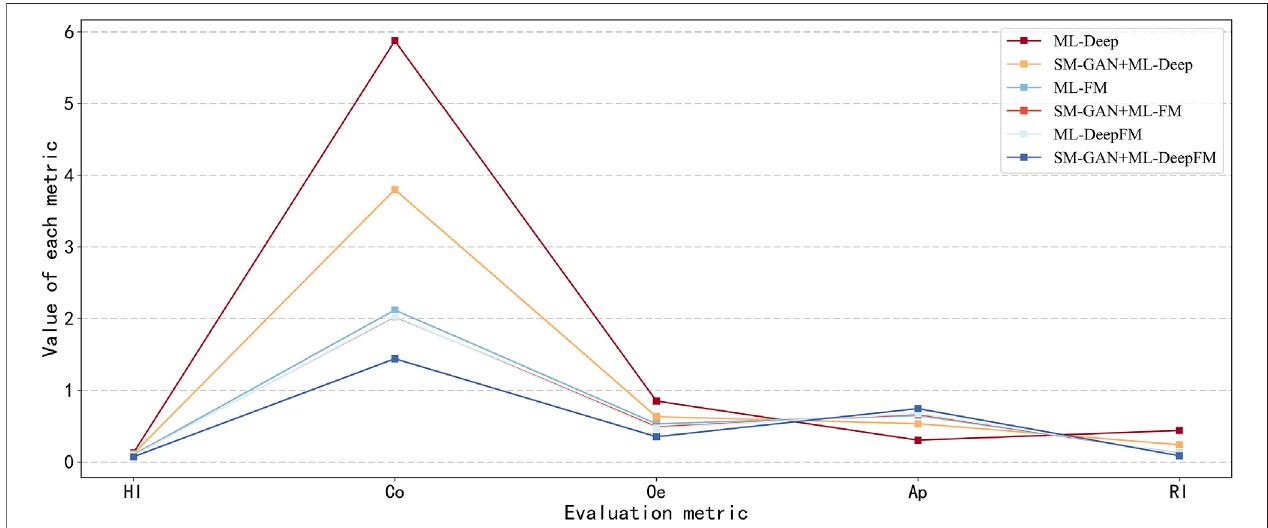
FIGURE 6 | The experimental results come from the exhaustive combination of SM-GAN and ML-DeepFM.